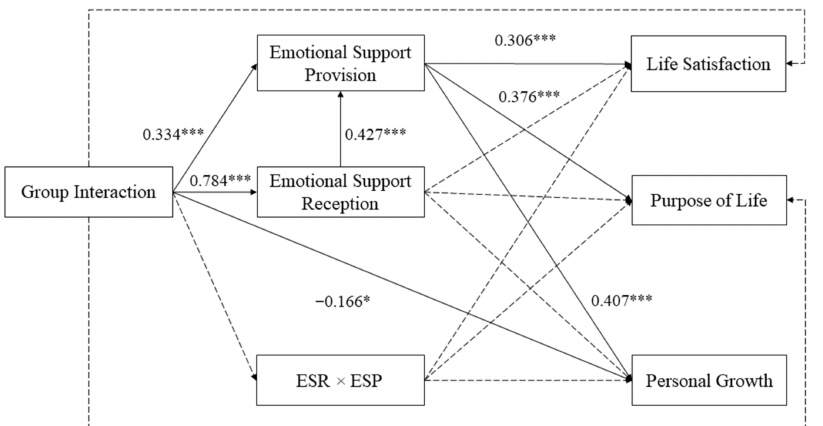
Figure 1. Standardized solutions for the integrated model with the control for background and baseline psychological well-being variables. Full lines represent significant relationships. Dotted lines represent non-significant relationships. ESR × ESP = emotional support reception (baseline) × emotional support provision (follow-up). * p < 0.05. *** p <